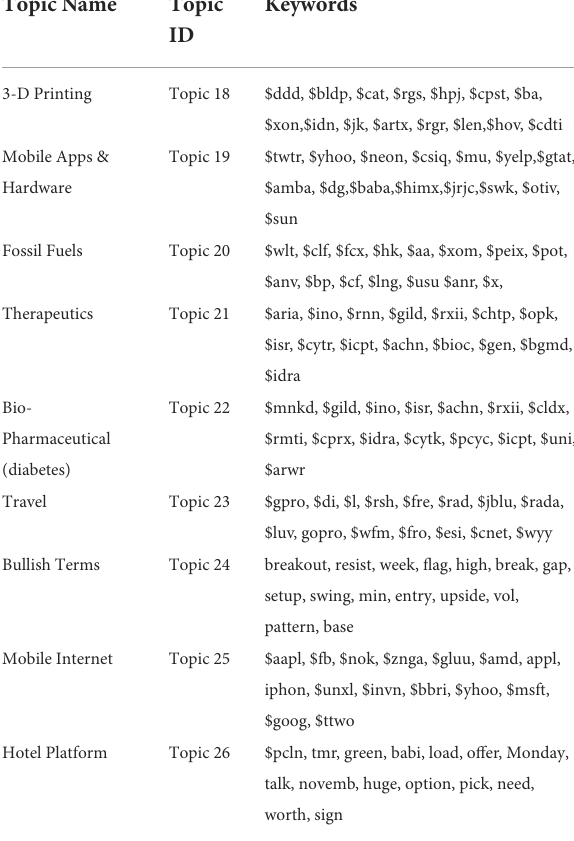
TABLE 1 The semantic meanings (topic names) of 26 topics on the grounds of the words mentioned in the highest marginal score and FREX words list